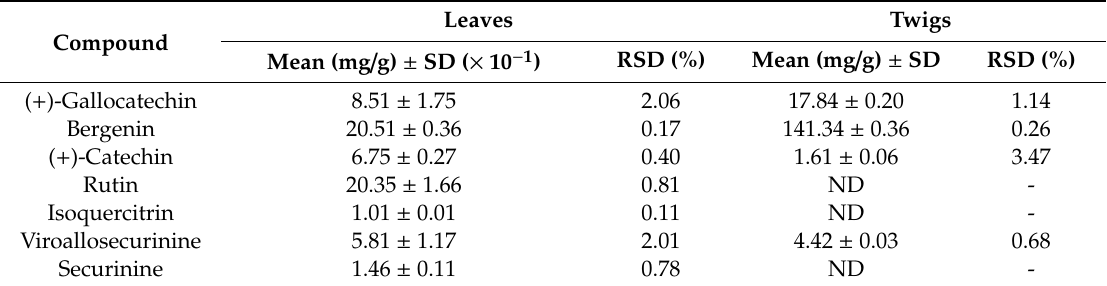
RSD: relative standard deviation, ND: not detected.